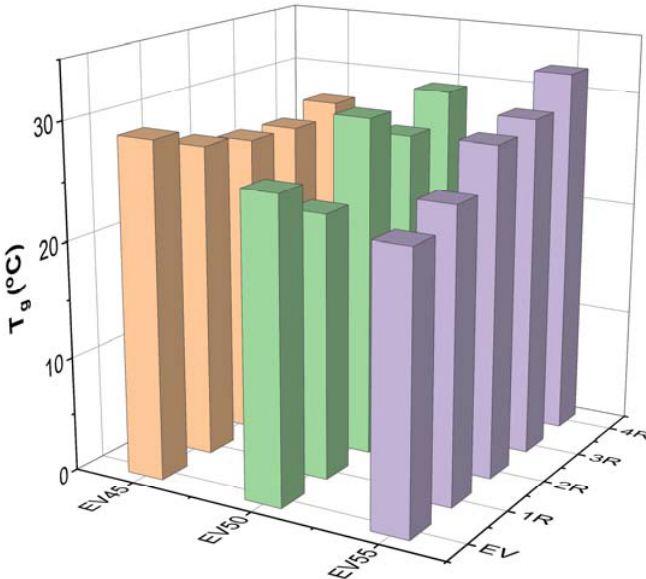
Figure 10. T g s of the original and recycled epoxy vitrimers.